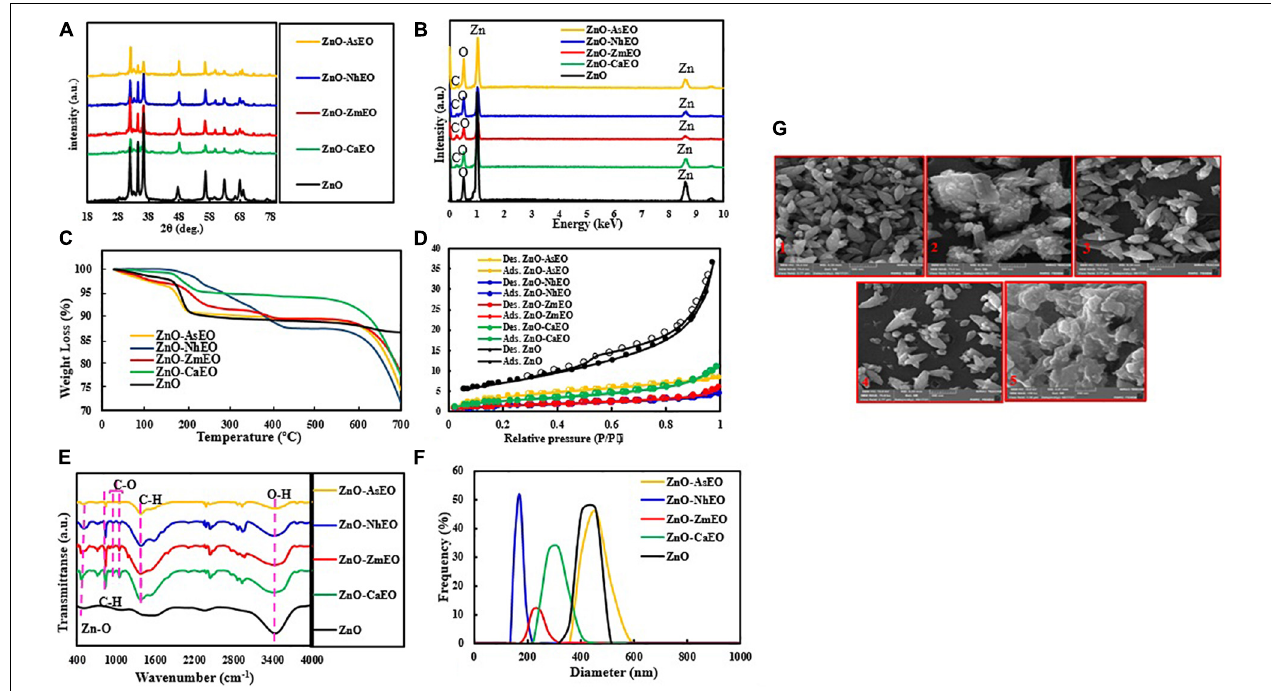
FIGURE 1 | (A) XRD patterns, (B) EDS spectra, (C) TGA diagrams, (D) BET plots, (E) FT-IR spectra, and (F) DLS analyses of the ZnO and ZnO-EO samples, and (G) SEM images of the prepared samples: 1, ZnO; 2, ZnO-CaEO; 3, ZnO-ZmEO; 4, ZnO-NhEO; and 5, ZnO-AsEO.